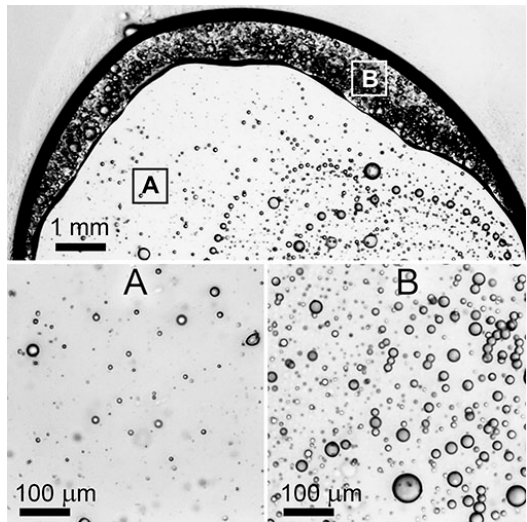
Figure 6. A micrograph of a drop of a PAN solution with 20% PDMS-400 in a narrow gap between two pieces of glass. The morphology along the radius is shown in inserts A (the middle part) and B (periphery).